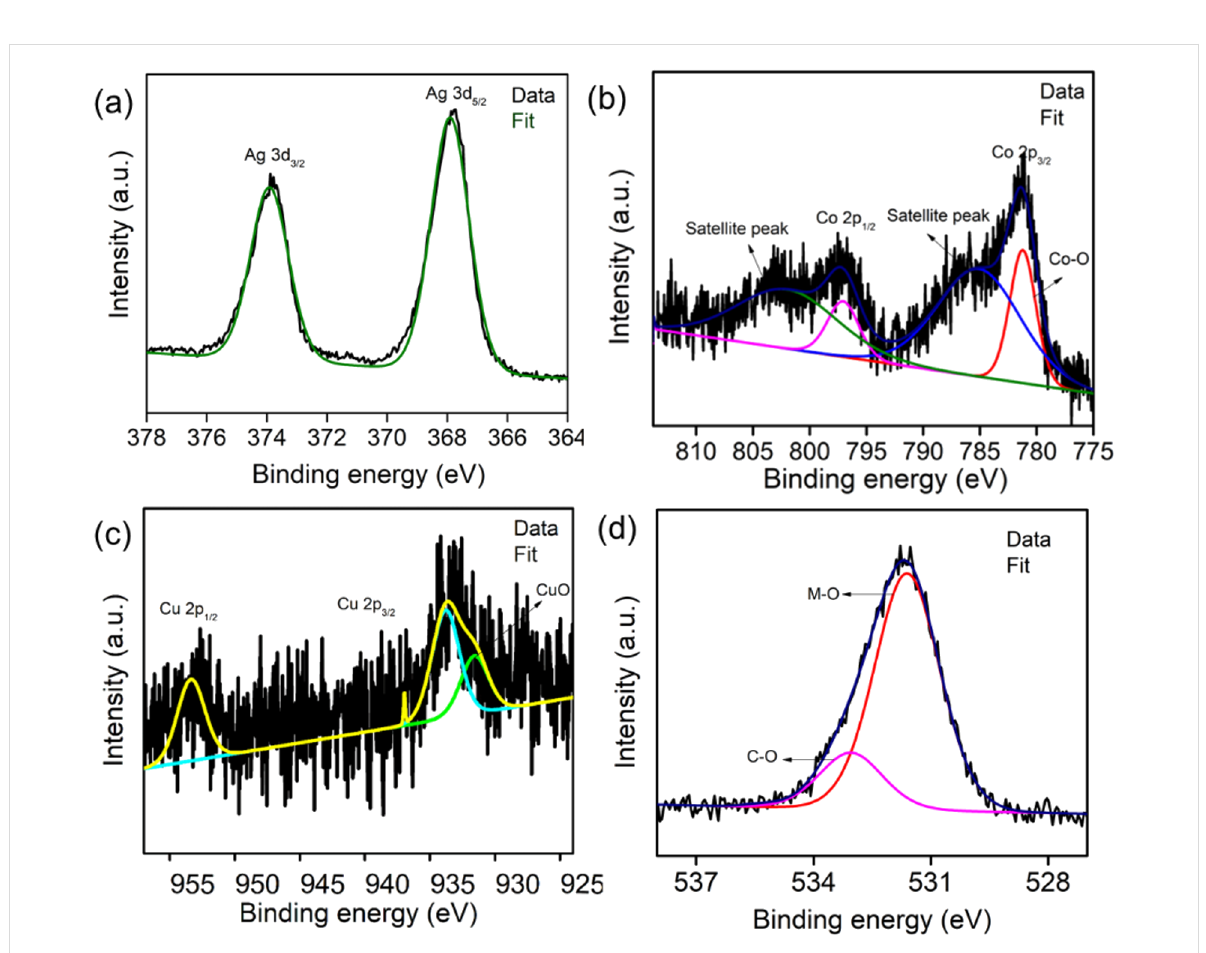
Figure 6: High-resolution XP spectra (a) Ag 3d, (b) Co 2p, (c) Cu 2p, and (d) O 1s of